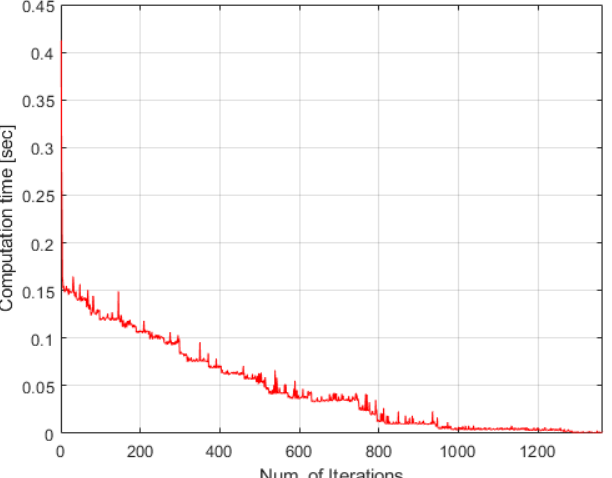
Figure 14. Computational time of TACTAR for a huge case applying a modified time-discounted reward scheme.